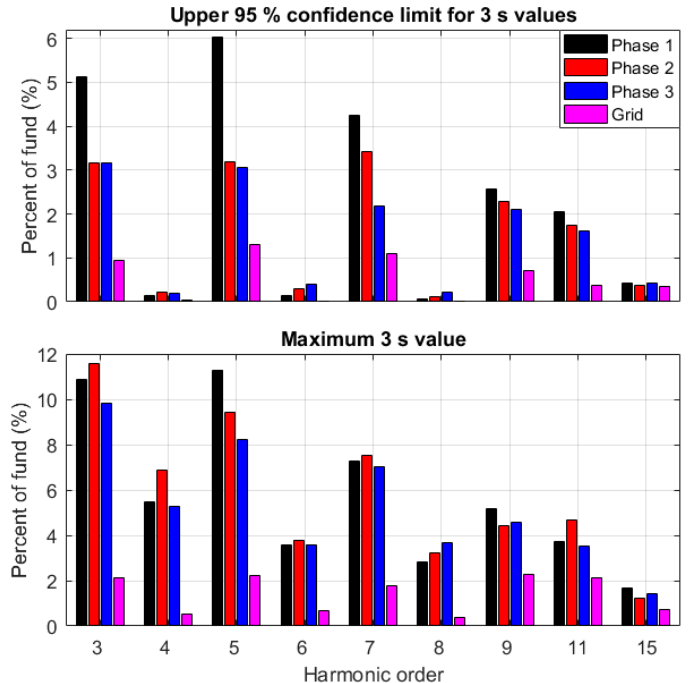
Figure 7. 3 s maximum 95% confidence limit value ( top ) and the maximum 3 s value in the measurements ( bottom ) for the odd harmonics 3rd to 11th and 15th and even harmonics 4th to 8th. The black, red and blue color represents phase 1 to 3 in islanded mode. Purple color represents all three phases during grid-connected operation.